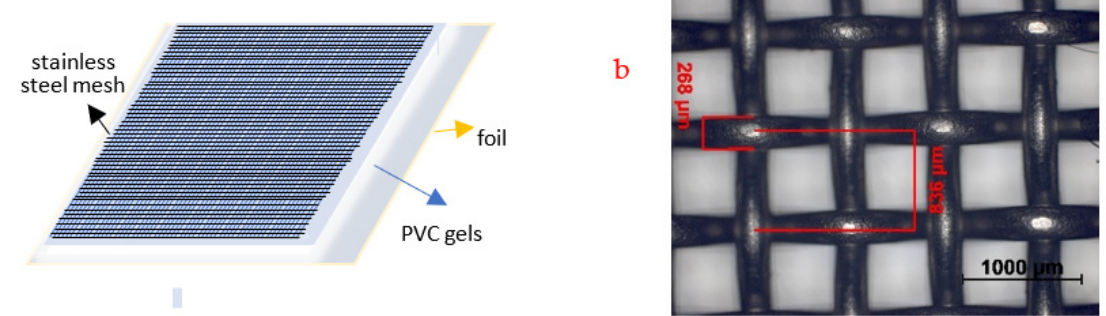
Figure 1. ( a ) Schematics of the PVC-gel actuator tested. ( b ) stainless-steel mesh.